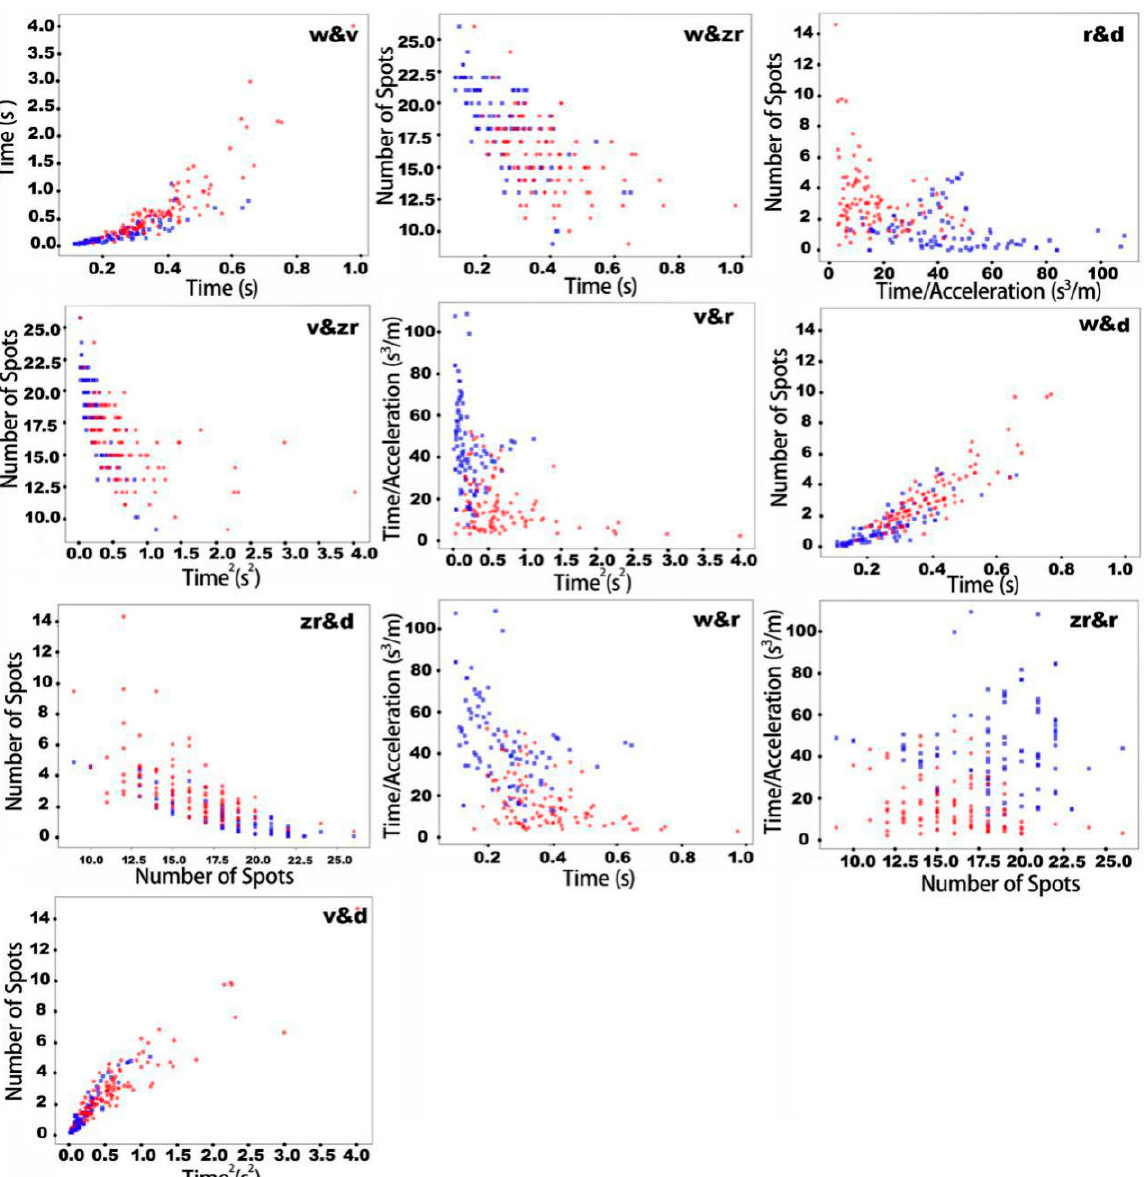
Figure 13. Plot of human fall (red dots) and object drop (blue dots) with different combined parameters (parameter 1: w, parameter 2: v, parameter 3: zr, parameter 4: r, parameter 5: d).